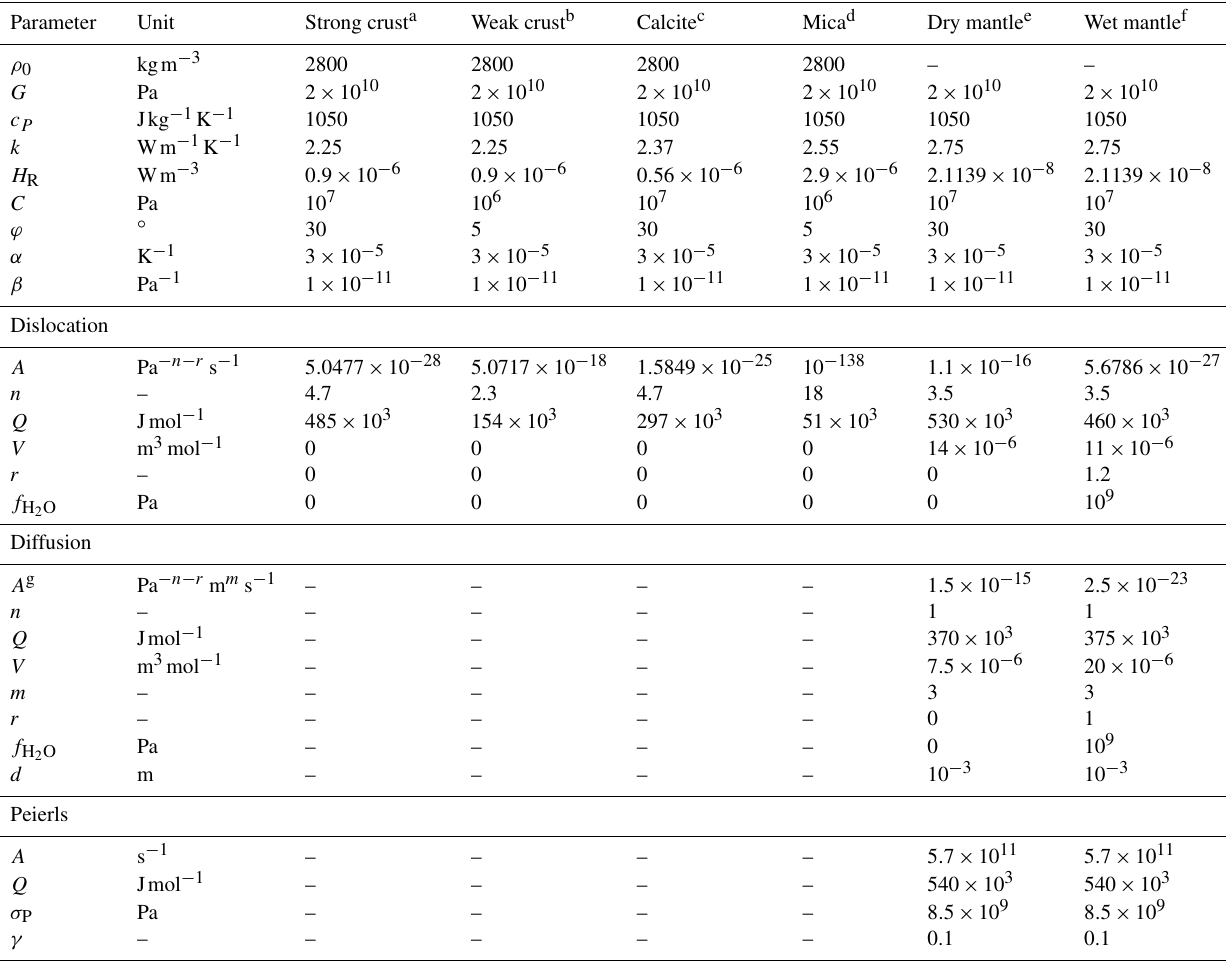
Table A1. Physical parameters used in the numerical simulations M1–6. Parameter